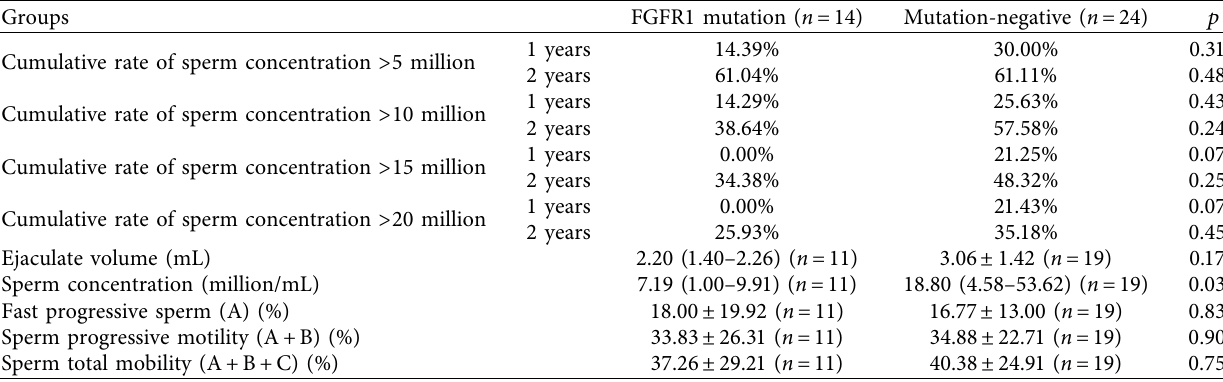
Table 4: Semen parameters after sperm-inducing treatment.